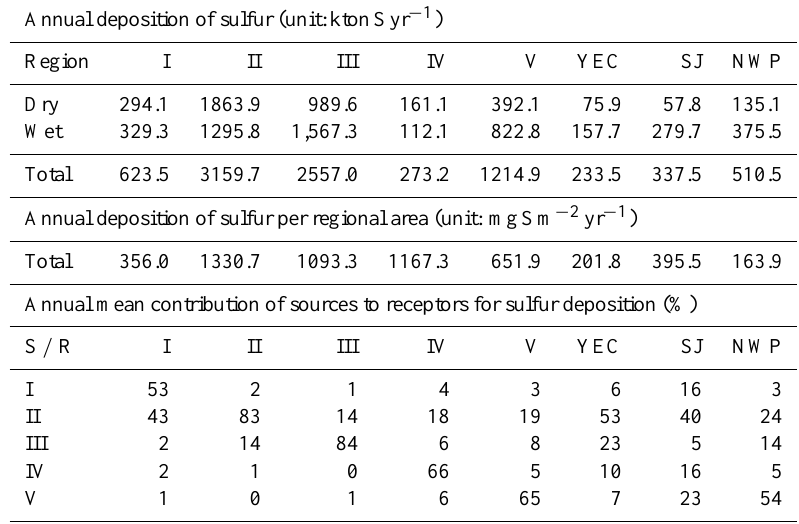
Table 4. Annual deposition (ktonSyr − 1 and mgSm − 2 yr − 1 ) of sulfur and contributions of source regions to receptor regions (%) in 2002. Annual deposition of sulfur (unit:ktonSyr − 1